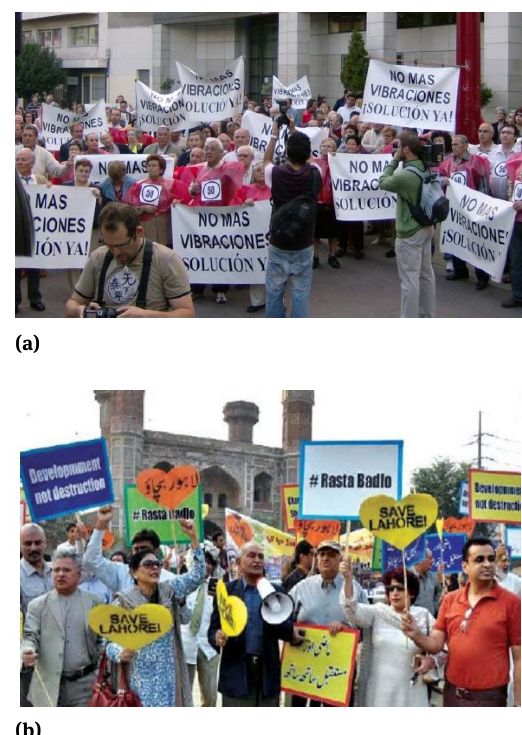
Figure 13: Street protests against SBN/SBV, (a) Lisbon city in Por- tugal (adopted from [50]) and (b) Lahore city in Pakistan (adopted from